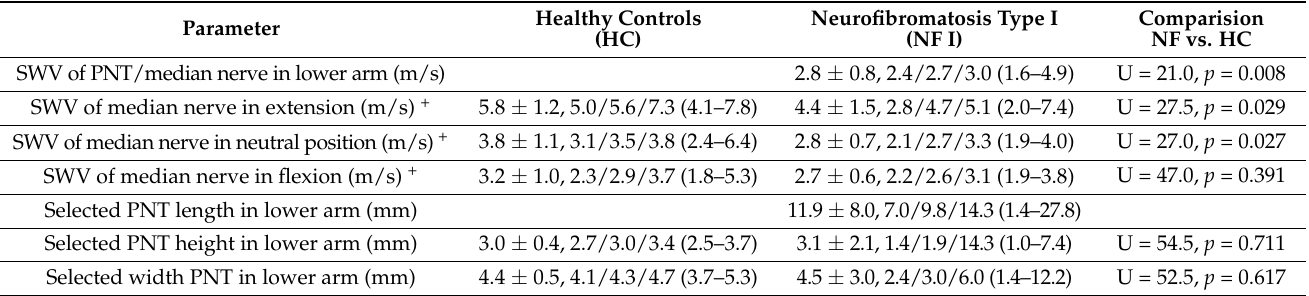
Table 2. Results for SWE in patients with neurofibromatosis type I and healthy